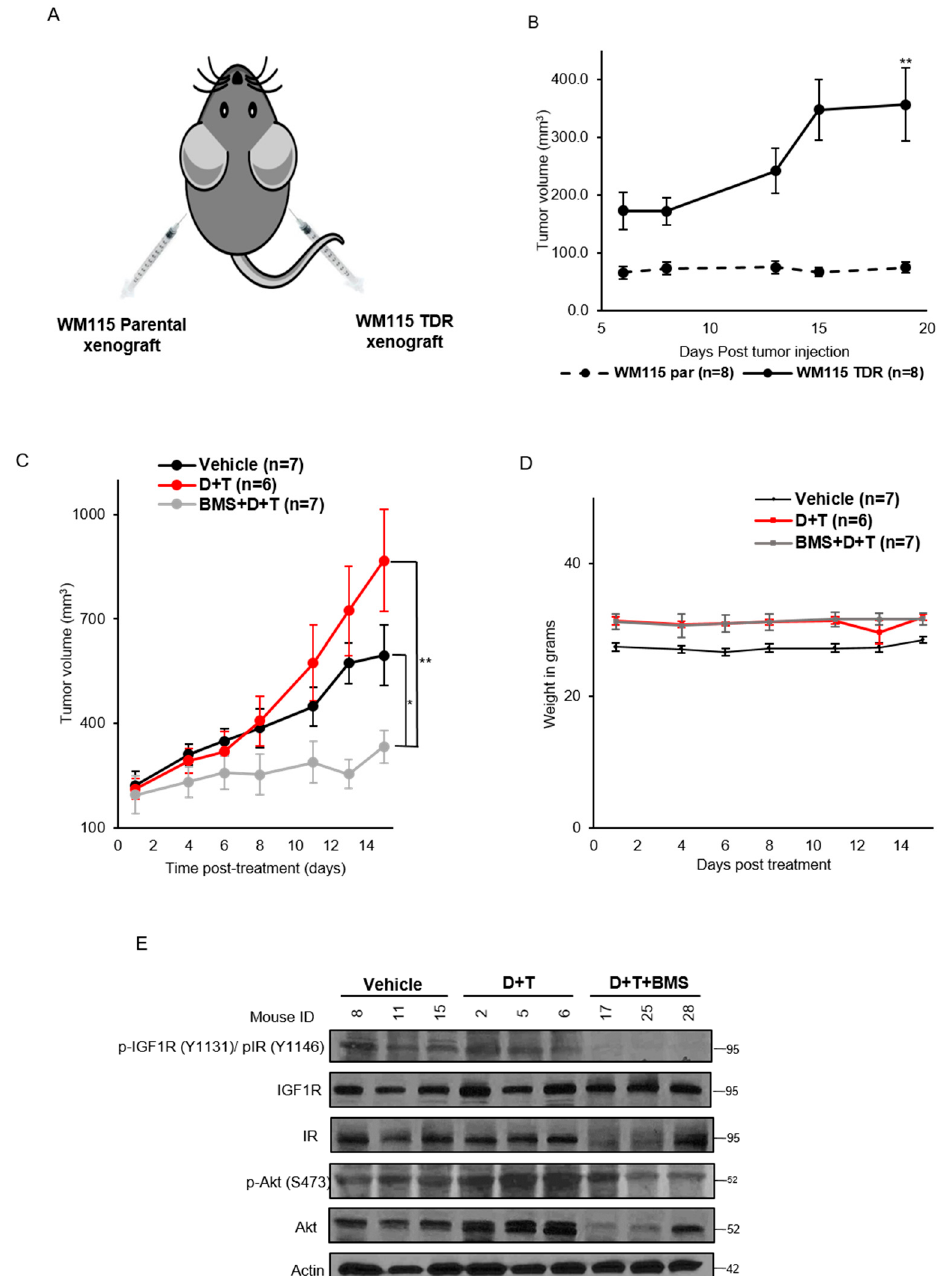
Figure 6. BMS-754807 inhibits tumor growth in WM115 TDR xenograft model. ( A ) Image of WM115 parental and TDR xenograft injection in nude mice. ( B ) Tumor growth kinetics of WM115 parental ( n = 8) and TDR xenograft ( n = 8) for 20 days post tumor injection. ( C ) Nude mice were injected with WM115 TDR cells and treated with vehicle, dabrafenib + trametinib (D + T), BMS-754807 (BMS), or the combination (BMS + D + T). Treatment was administered for 2 weeks by oral route. Tumors were measured thrice a week with calipers. Each data point represents the mean tumor volume ± SEM ( n = 6–7). All data plotted as mean ± SEM. * p < 0.05, ** p < 0.005 calculated using Student’s t -test. ( D ) Mice weight was recorded post treatment with BMS-754807 in combination with dabrafenib and trametinib and represented. ( E ) p-IGF1R/p-IR and p-Akt expressions were assessed in the tumor lysate by Western blot. Actin served as loading